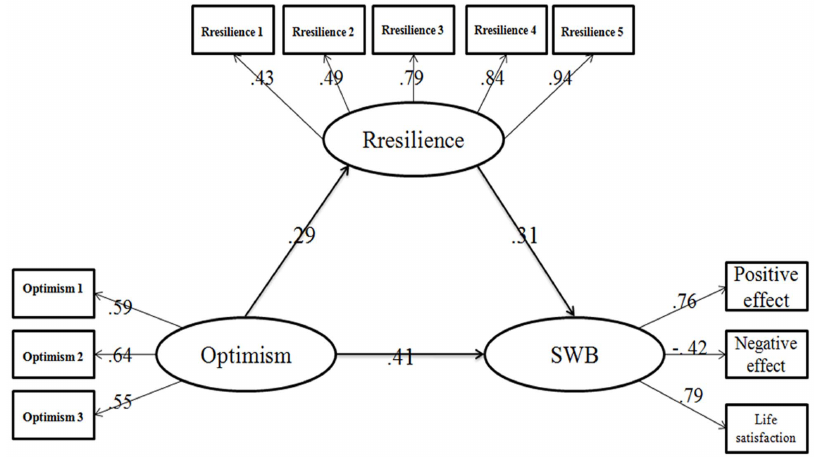
Figure 1. The full model of optimism, psychological resilience and subjective well-being. doi:10.1371/journal.pone.0082939.g001 PLOS ONE |